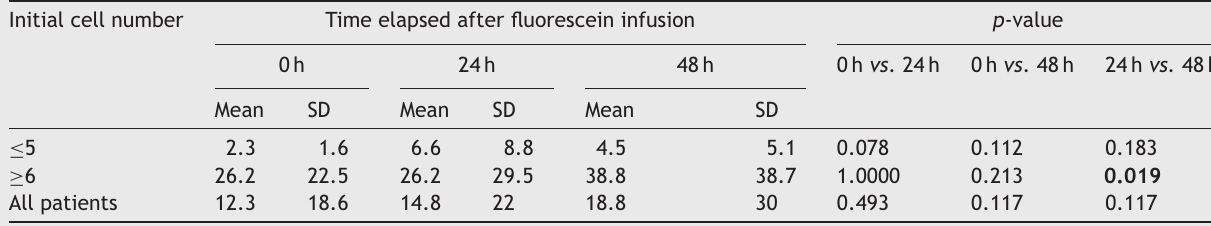
Number of cells according to time course and initial cell number. Initial cell number